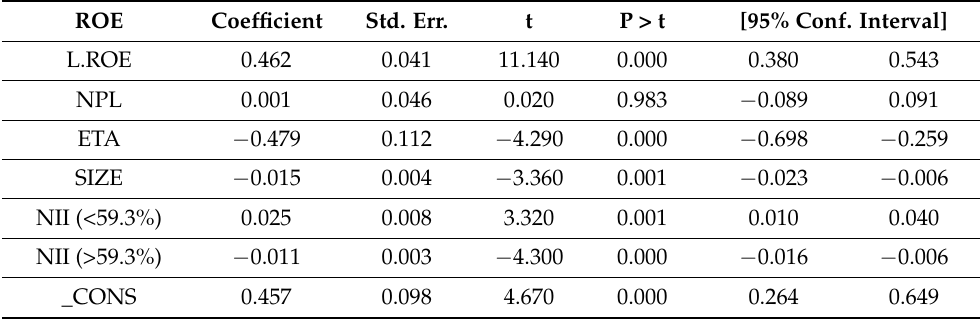
Table 11. The impact of non-interest income on the performance of commercial banks corresponds to the threshold of non-interest